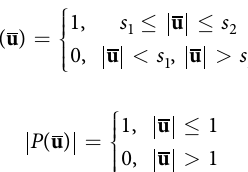
Figure 5. The imaginary part of WOTF (phase WOTF) when the thickness of the annulus varies ( NA obj = 0.8, λ = 550 nm , the spatial frequency coordinate is normalized against the coherent resolution limit NA Δ s = 0.1; ( b ) Δ s = 0.4; ( c ) Δ s = 0.75; ( d ) Δ s =